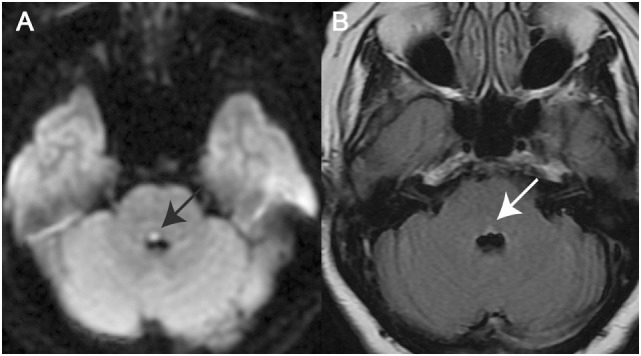
Magnetic resonance imaging (MRI) in two illustrative cases with internuclear ophthalmoplegia (INO). (A) Axial diffusion-weighted imaging–MRI in a patient with unilateral INO (patient 7) demonstrating a right-sided paramedian dorsal pontine lesion (black arrow). (B) Axial fluid-attenuated inversion recovery-image in a patient with bilateral INO (patient 19) showing a hyperintense bilateral paramedian dorsal pontine lesion (white arrow).